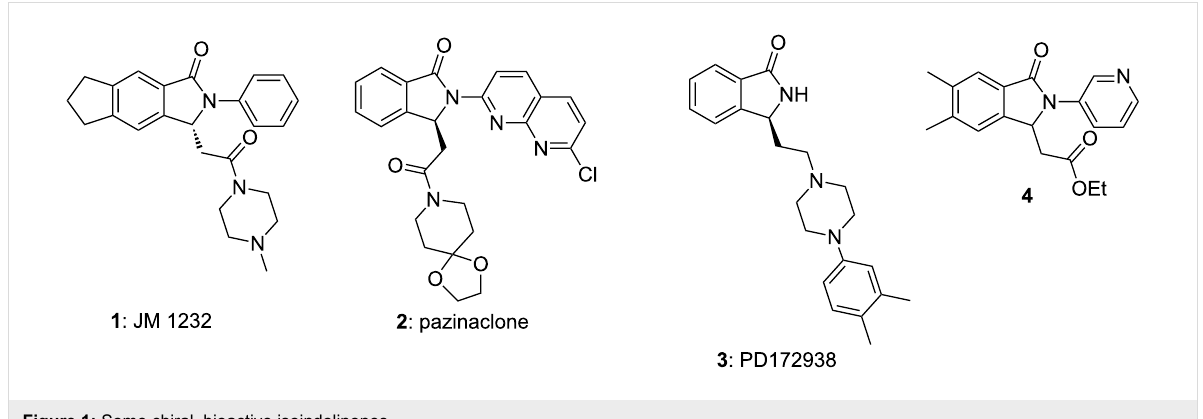
Figure 1: Some chiral, bioactive